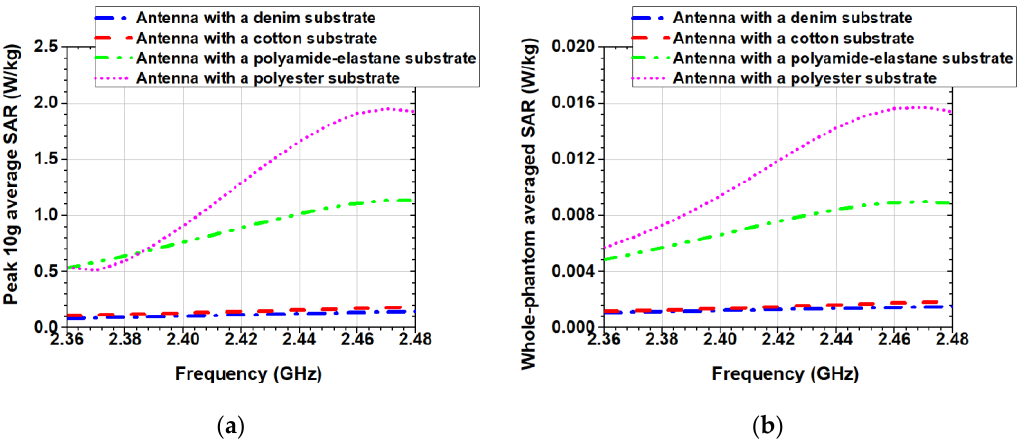
Figure 12. Simulated: ( a ) Peak 10 g average SAR (W / kg); ( b ) Whole-phantom averaged SAR (W / kg). In MBAN and ISM bands, and for an input power of 100 mW, the whole-phantom averaged SAR for the antennas with denim and cotton substrates is below 0.002 W / kg (about 40 times lower than the maximum allowed value of 0.08 W / kg), as seen in Figure 12b. The obtained whole-phantom averaged SAR for the antennas with polyamide-elastane and polyester substrates is 10 and five times lower than the maximum allowed value of 0.08 W / kg, respectively.